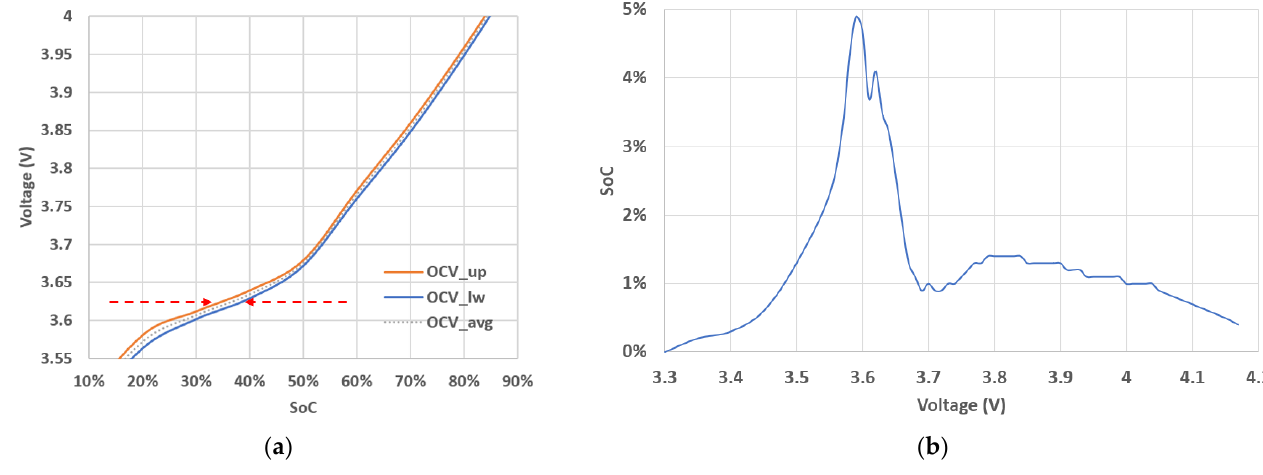
Figure 1. ( a ) OCV curves of a 18650 type battery [27] during charge and discharge; ( b ) SoC discrep- ancy between OCV curves during battery charge and